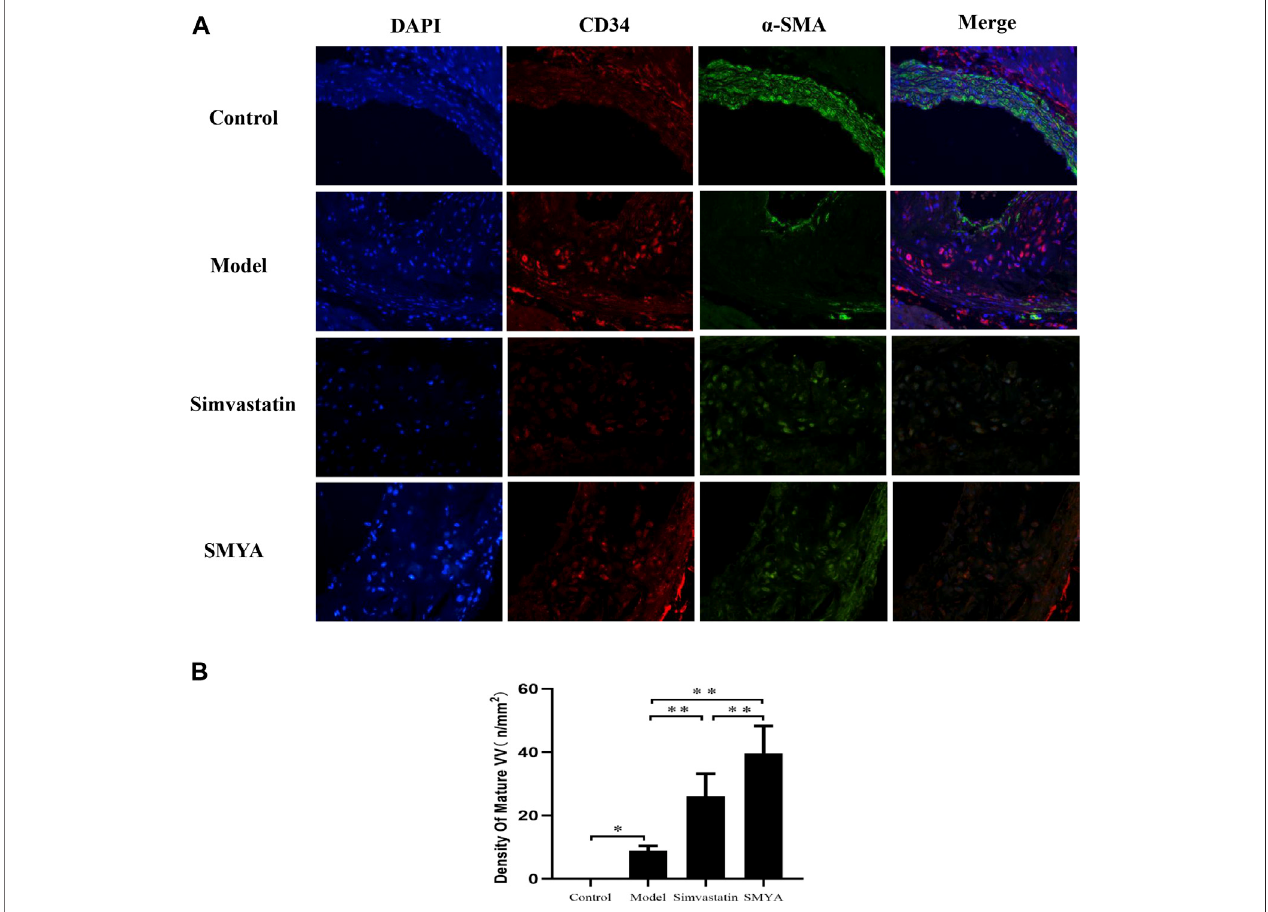
FIGURE6 | Effectof SMYA on VV Maturation. Double-labelling Immuno fl uorescence showed:in control group, there wasno plaquein aortic root. In model group, therewereafewmatureVVcoveredbysmoothmusclecellsinaorticrootplaques.Comparedwiththemodelgroup,thedensityofmatureVVwassigni fi cantlyincreased inaorticrootplaquesinboth thesimvastatin andSMYAgroups.Compared withsimvastatingroup,thedensity ofmatureVVincreasedmoresigni fi cantlyinSMYAgroup (Magni fi cation, × 400). (B) quantitative analysis of SMYA on VV maturation in aortic root plaques. Data are expressed as mean ± SD. *p < 0.05, **p < 0.01.